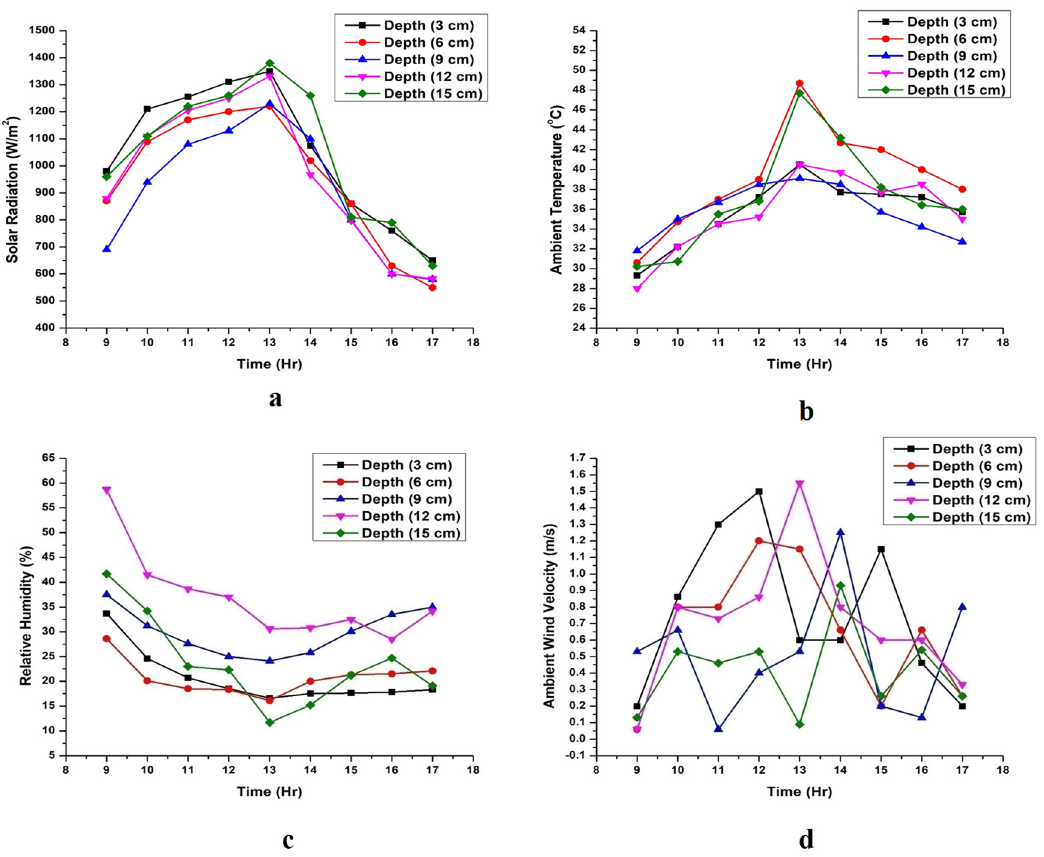
Figure 3. ( a – d ) Variation of Solar radiation, Ambient temperature, Relative humidity, and Ambient wind velocity vs. time.